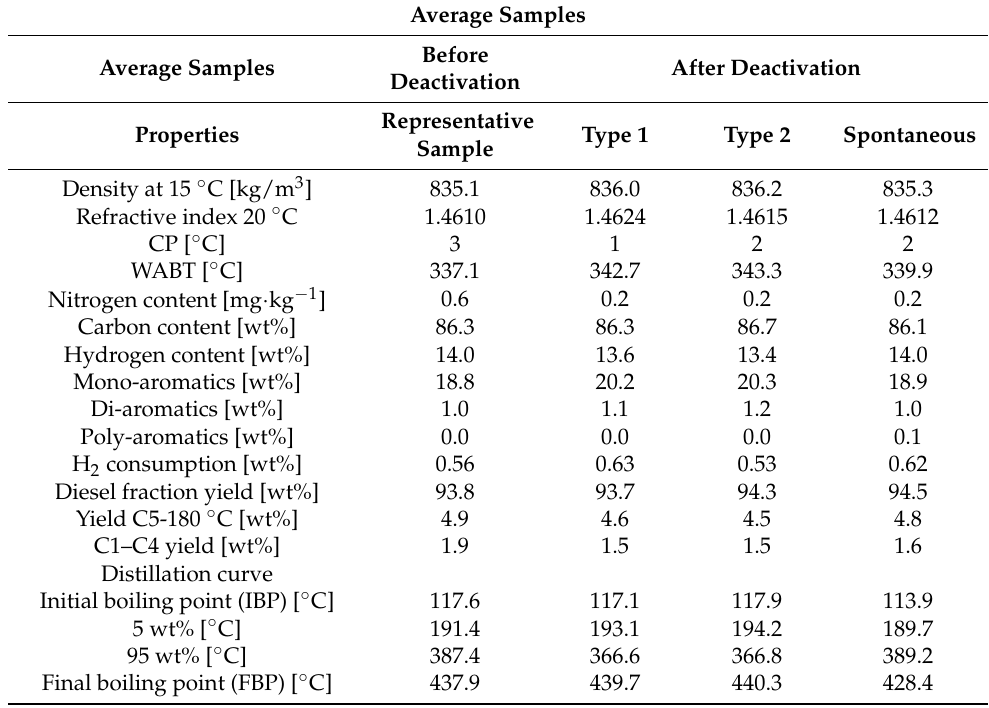
Table 4. Evaluation of the average products and mass balances for the first and second